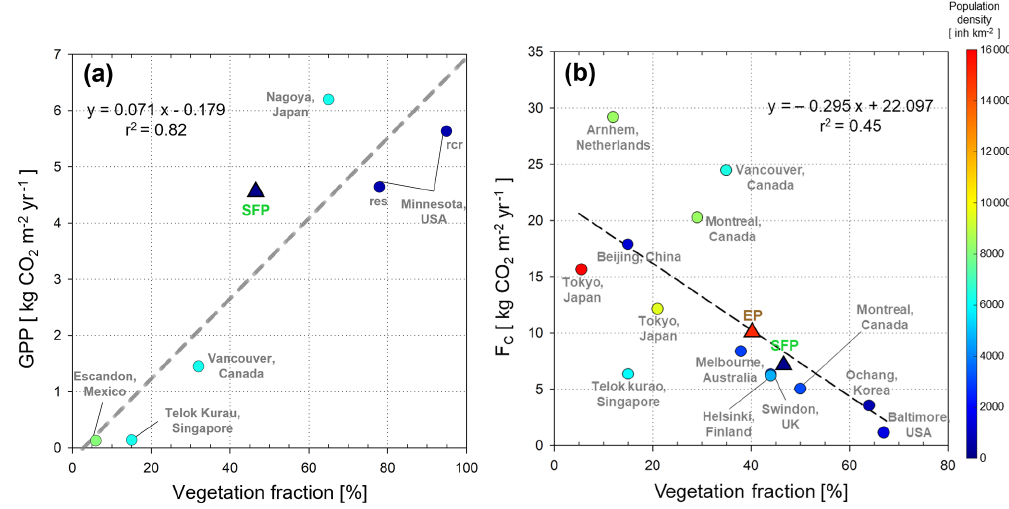
Figure 12. Relationship between vegetation fraction (a) annual GPP and (b) annual F C in urban sites. Dashed line in panel (a) and (b) indicates a linear regression of GPP in urban sites from Awal et al. (2010), Crawford and Christen (2015), Velasco et al. (2016), and Menzer and McFadden (2017) as well as NEE from Hong et al. (2019b) and references therein scaled with vegetation fraction, respectively. See main texts for more information.